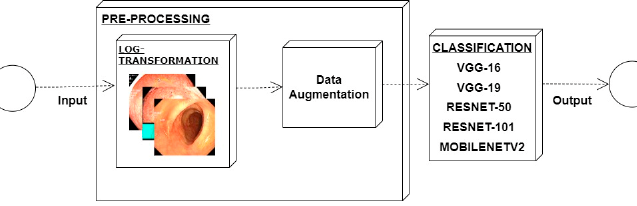
Figure 4. System architecture after applying log transformation.